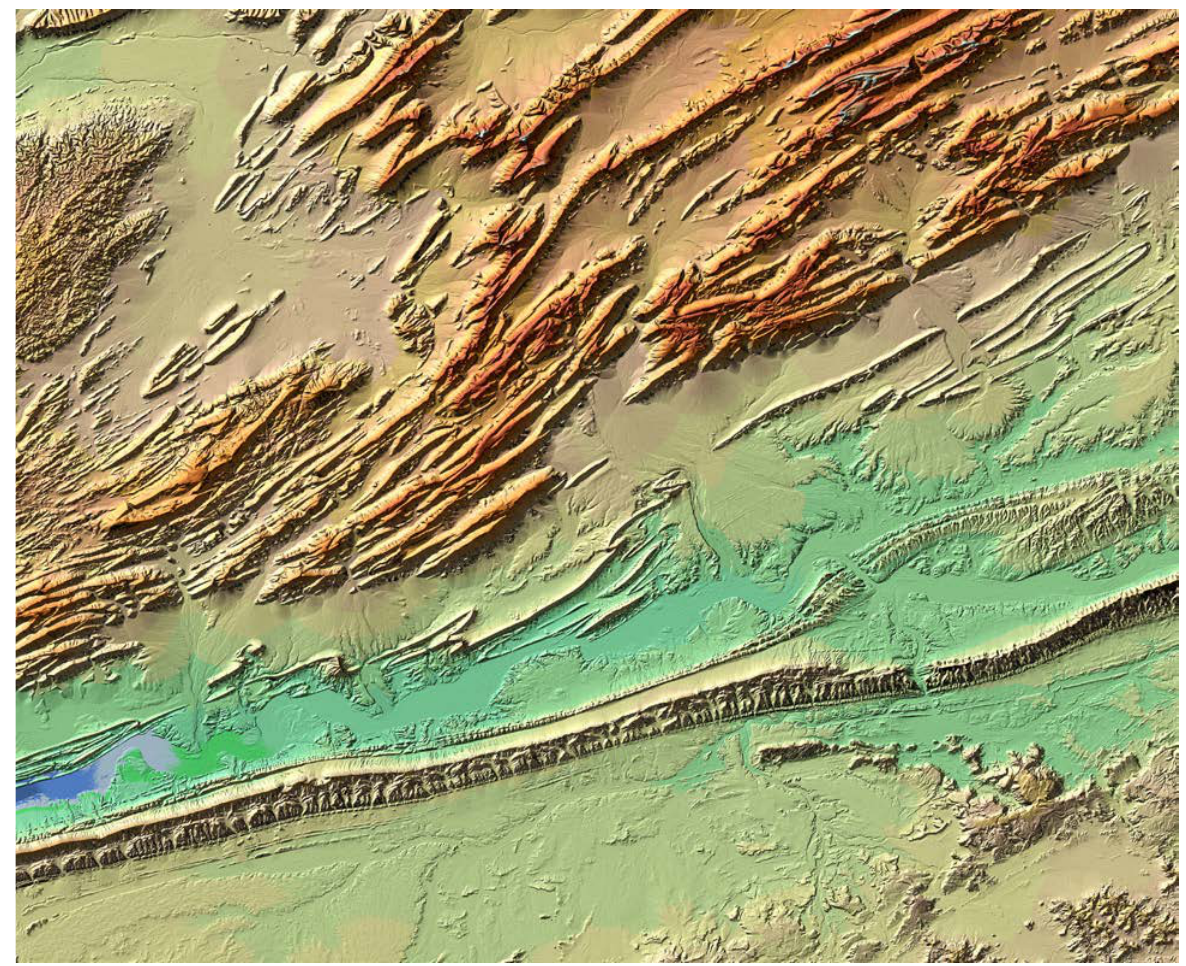
Figure 5. Final TanDEM-X DEM over Guelmim Es Semara,